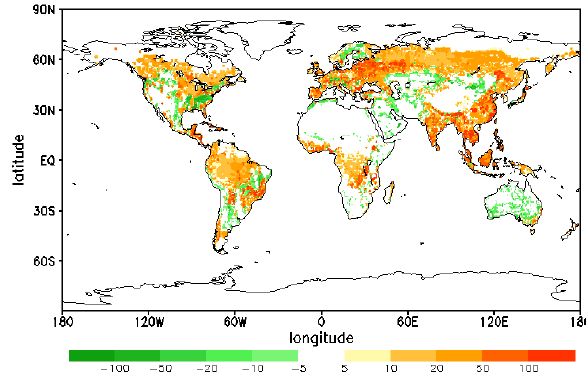
Figure 3. ISAM estimated spatial distributions of carbon emissions from land use change Fig. 3. ISAM estimated spatial distributions of carbon emissions in the 1990s (Unit: gC/m 2 /yr). Positive values represent net C release to the atmosphere from land use change in the 1990s (Unit: gC/m 2 /yr). Positive val- and negative values represent net C storage in the terrestrial biosphere. ues represent net C release to the atmosphere and negative values represent net C storage in the terrestrial